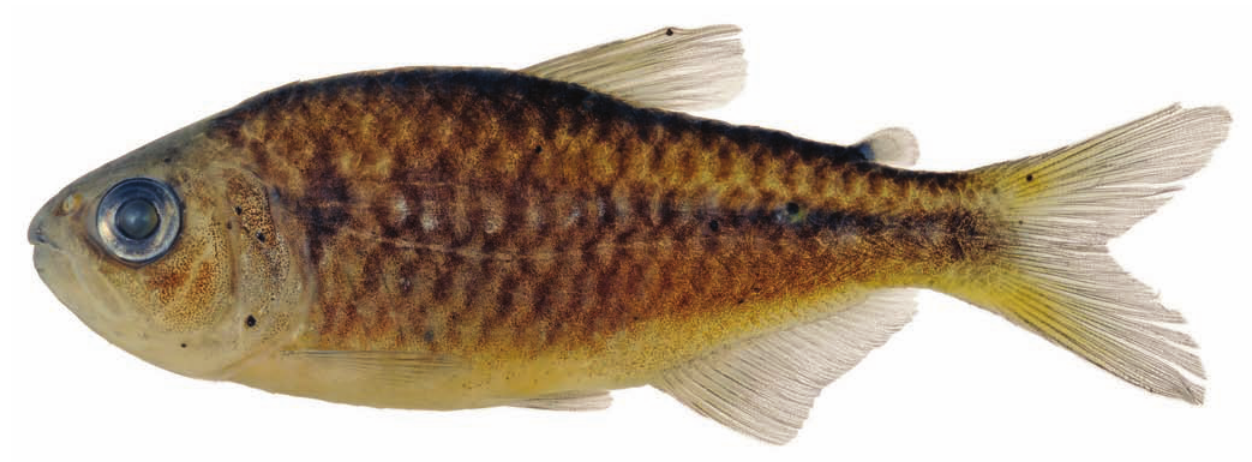
Fig. 1. Moenkhausia chlorophthalma , holotype, MZUSP 99412, 67.4 mm SL, Brazil, Pará, Altamira, rio Treze de Maio, tributary to rio Curuá, rio Iriri basin, rio Xingu